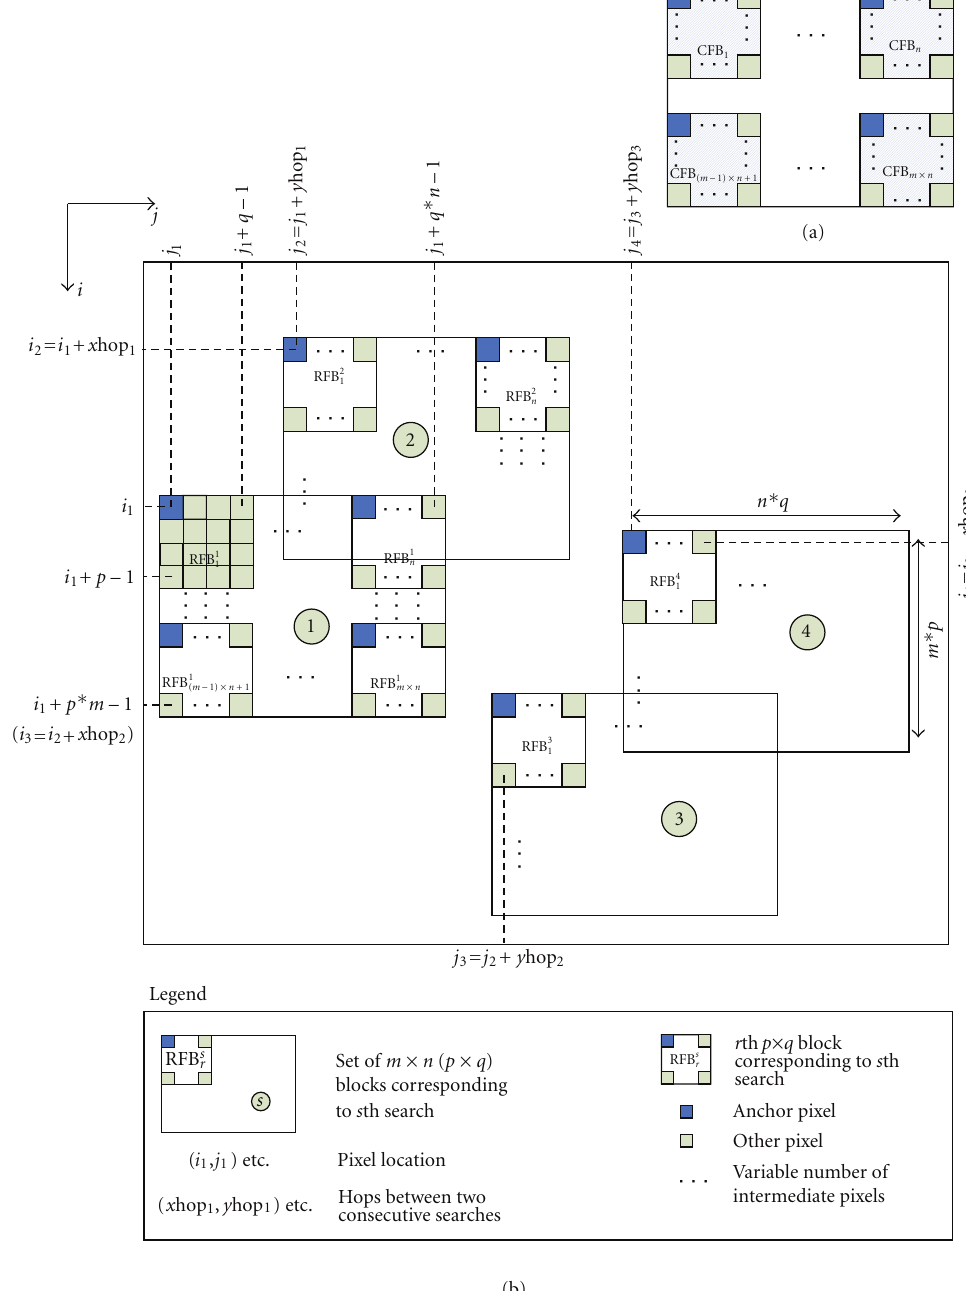
Figure 4: Illustration of data access for block size p × q and a modified diamond search pattern (a) Current frame blocks (b) Reference frame blocks inside the search